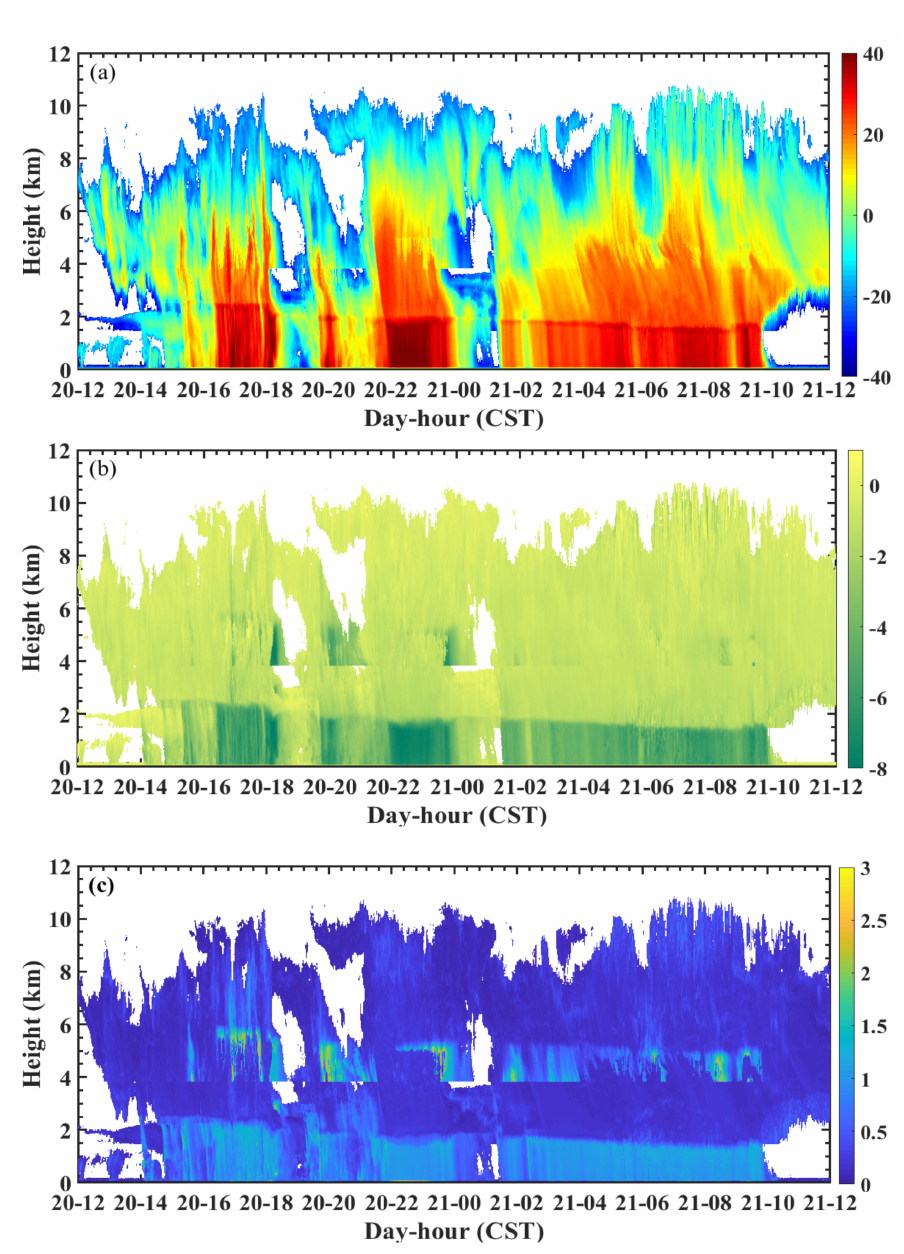
Figure 10. Time–height profile of the ( a ) radar reflectivity factor (dBZ), ( b ) Doppler velocity (m · s − 1 ), and ( c ) velocity spectrum width (m · s − 1